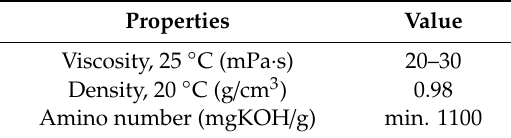
Table 2. Properties of triethylenetetramine curing agent [28].